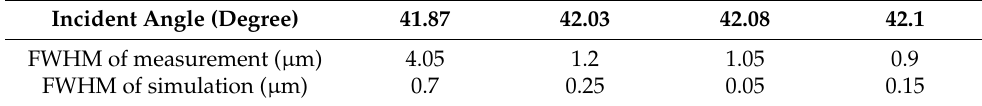
Table 2. Sensor characteristics for Kretschmann and Otto configurations.